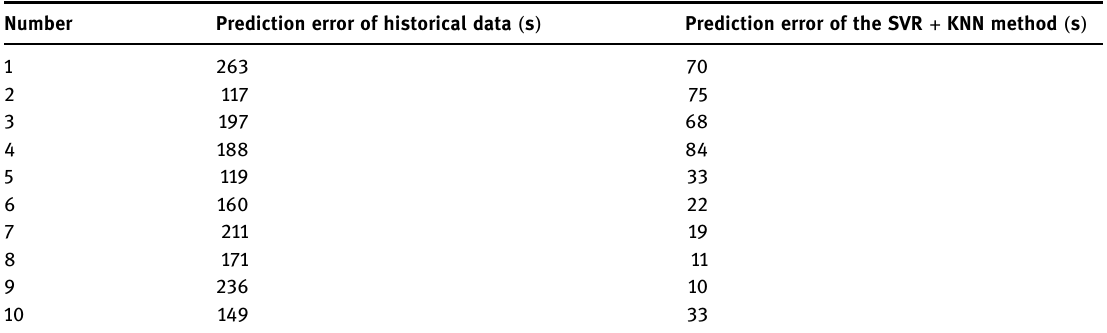
Table 4: Comparison of prediction